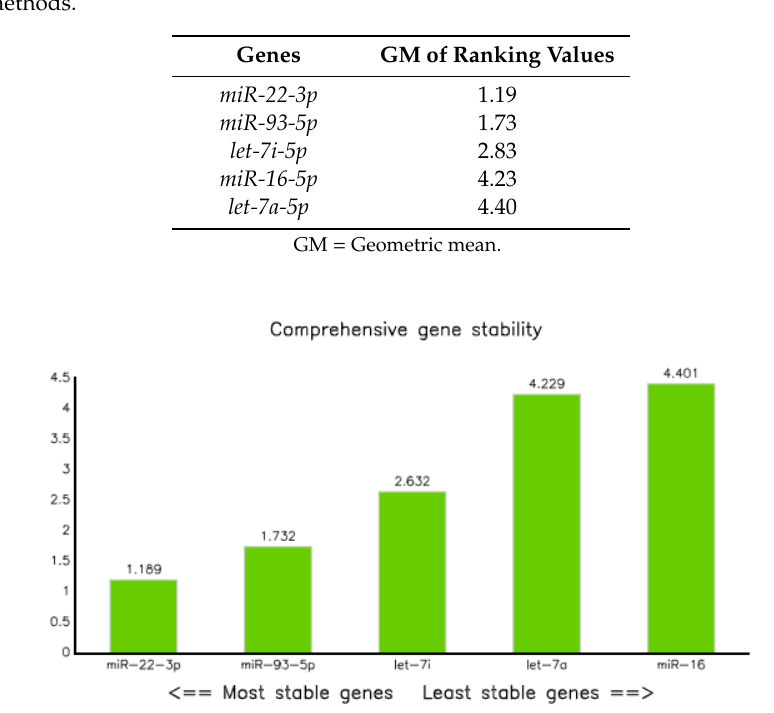
Figure 7. Gene stability graph performed by the comprehensive ranking method.